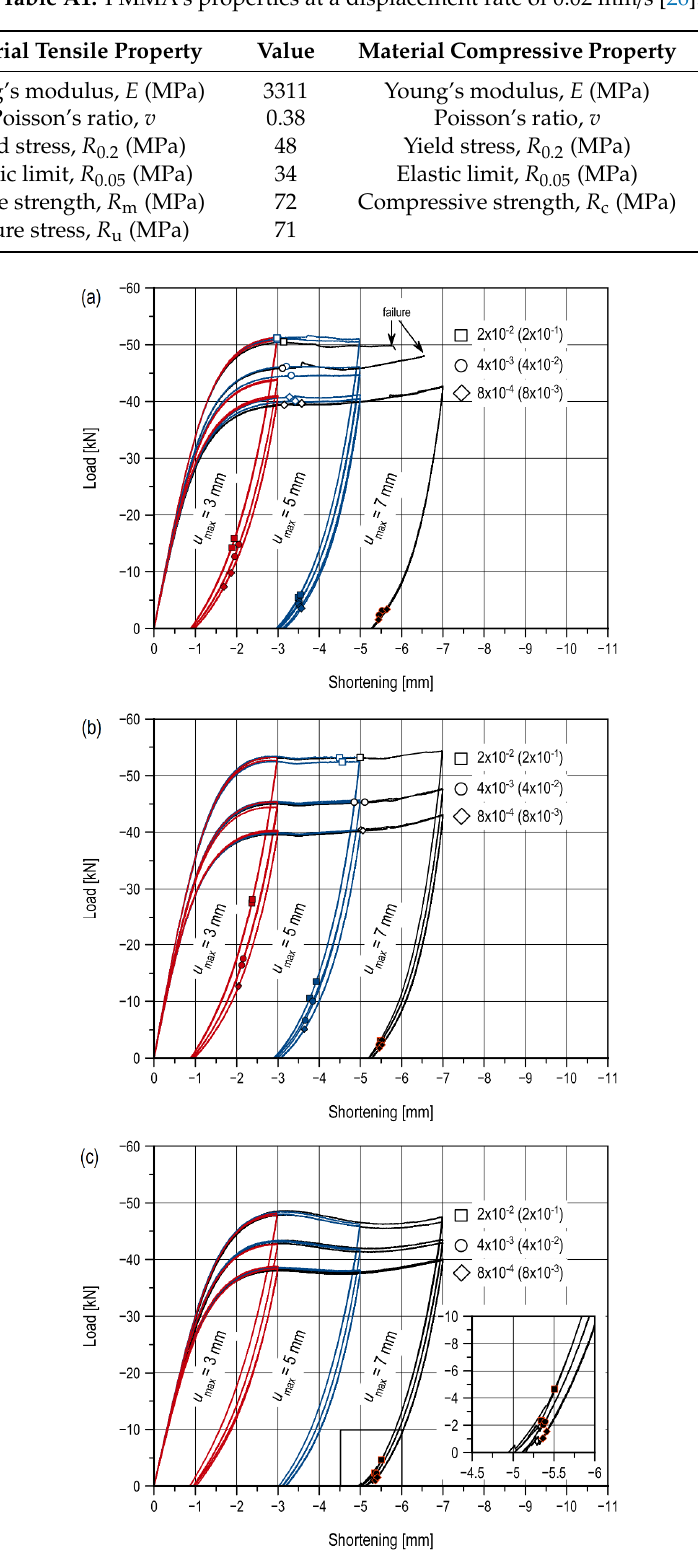
Figure A1. Compression curves with fracture initiation points for the V-notched specimens with ( a ) a root radius R ≈ 0 mm; ( b ) root radius R ≈ 1 mm; and ( c ) for the U-notched specimens ( t 2 = 14.5 mm).